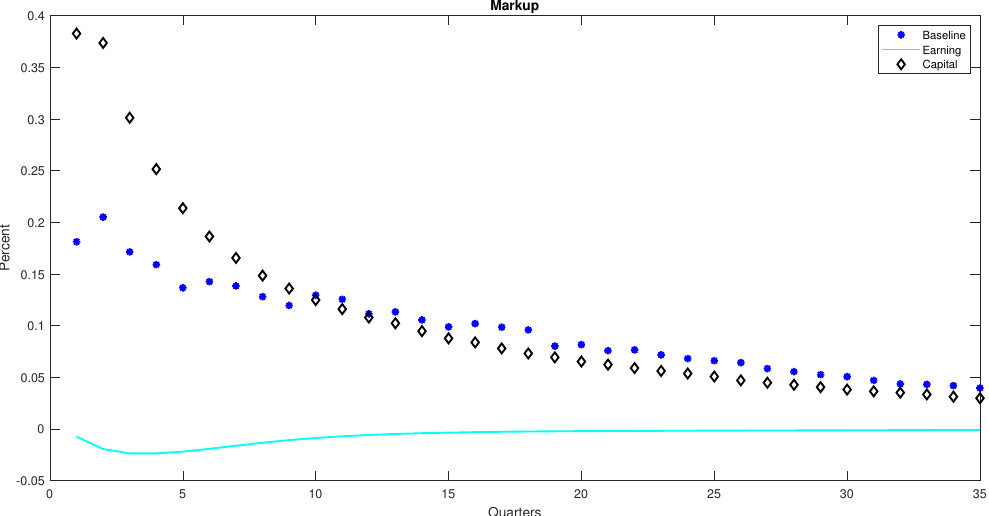
Figure 4. Impulse Responses of the Price Markup to a Productivity Uncertainty Shock under Alterna- tive Borrowing Constraints. Notes : The figure displays model IRFs of the markup to a productivity uncertainty shock. The cyan colored lines represent the model with earnings-based constraint, the black diamonds represent the model with asset-based constraints, whereas the responses with blue stars represent the baseline model without any financial frictions. The parameter sets that generate = the IRFs are presented in Table 2. In addition, we set ρ σ = 0.4 and σ σ A t